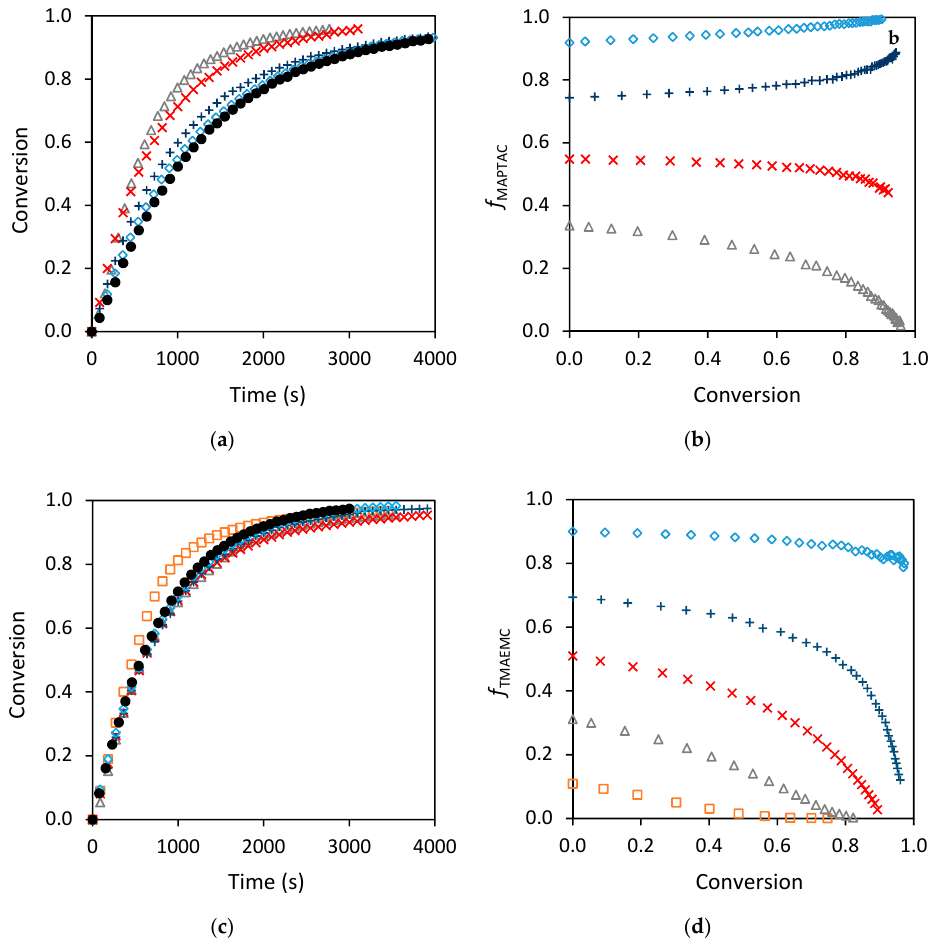
Figure 3. Overall monomer conversion profiles for ( a ) AA-MAPTAC and ( c ) AA-TMAEMC, and composition drift of ( b ) MAPTAC and ( d ) TMAEMC mole fraction when copolymerized with AA at 50 °C with 0.80 (for MAPTAC) and 0.40 wt% (for TMAEMC) V-50, w mon,0 = 0.10 and different initial monomer compositions ( f MAPTAC,0/TMAEMC,0 = 0.1( ), 0.3( Δ ), 0.5(×), 0.7(+), 0.9( ◊ ), 1( ● )).